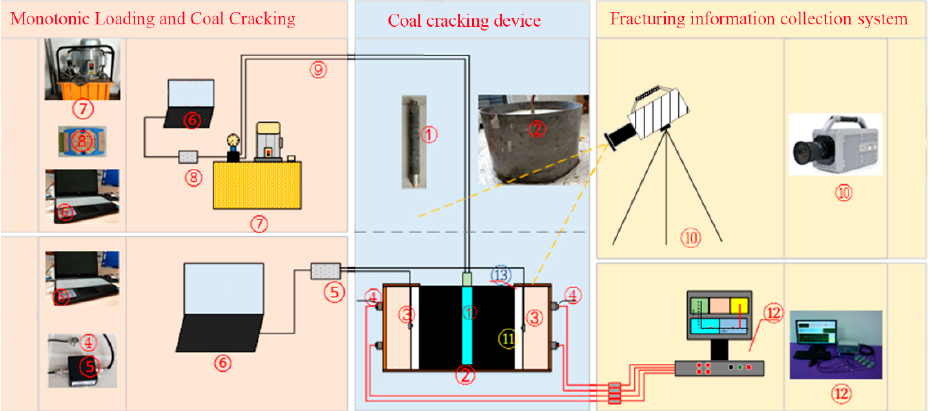
Figure 8. Experimental platform for fracture of coal and rock under different forms of load (1, expansion tube; 2, cracking drum; 3, pressure sensor; 4, AE sensor; 5, signal transmitter; 6, computer; 7, hydraulic pump station; 8, data acquisition card; 9, hydraulic conveying pipe; 10, high-speed camera; 11, coal sample; 12, acoustic emission instrument; 13, static crushing agent (ground stress loading)). Figure 9. Mechanical microstructure.